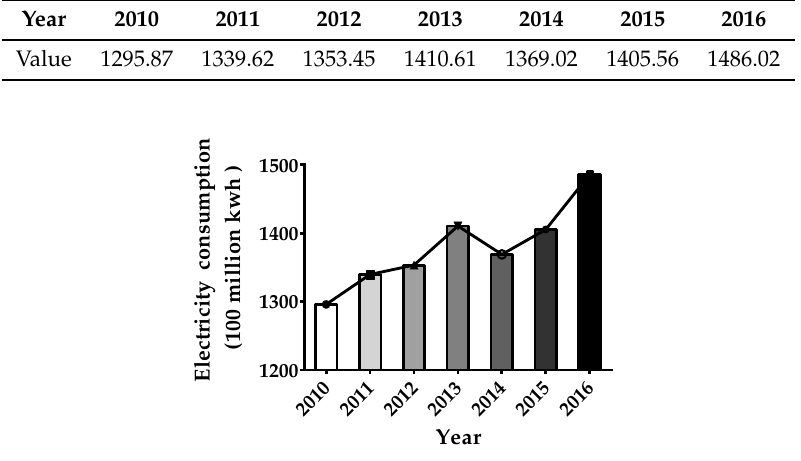
Figure 2. The electricity consumption for Shanghai City in China from 2010 to